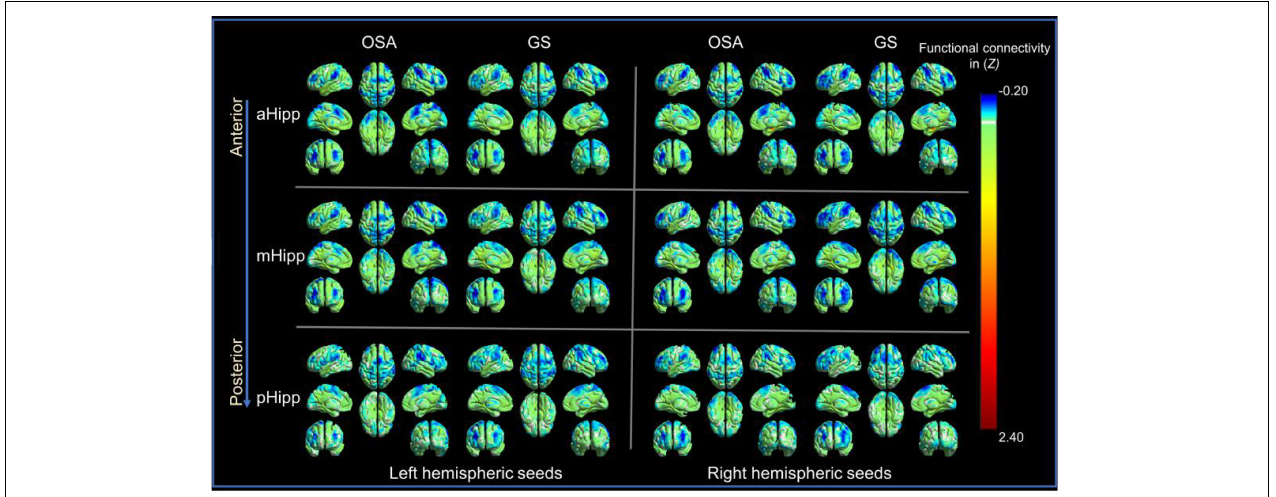
FIGURE 2 | The distribution patterns of resting-state functional connectivity (FC) in different hippocampal subdivisions in the obstructive sleep apnoea (OSA) group and good sleepers (GS) group were highly similar. Panel (A) is for those in the OSA group; Panel (B) is for those in the GSs group. TABLE 2 | Differences in functional connectivity (FC) of hippocampal subregions between OSA and GSs. Hippocampal subregions Brain regions Voxel number Peak MNI coordinates t -value